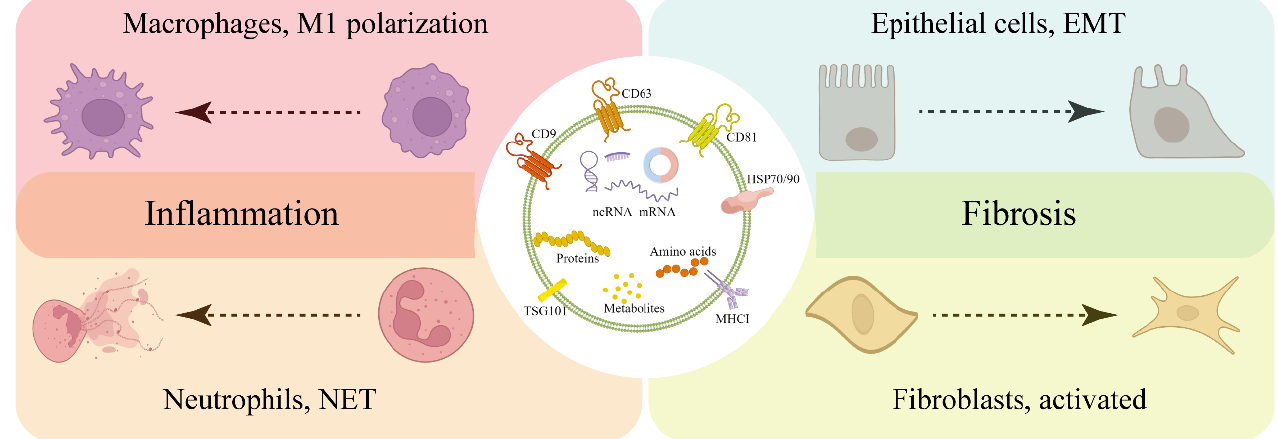
Figure 3. Mastitis-associated exosome-mediated intercellular communication. Mastitis-associated exosomes may mediate intercellular communication in various models of cell interactions, such as exosomes ingested by macrophages, and affect their M1-type polarization: ingested by neutrophils regulates its NET formation, ingested by epithelial cells promotes its EMT, and ingested by fibroblasts affects its activation.